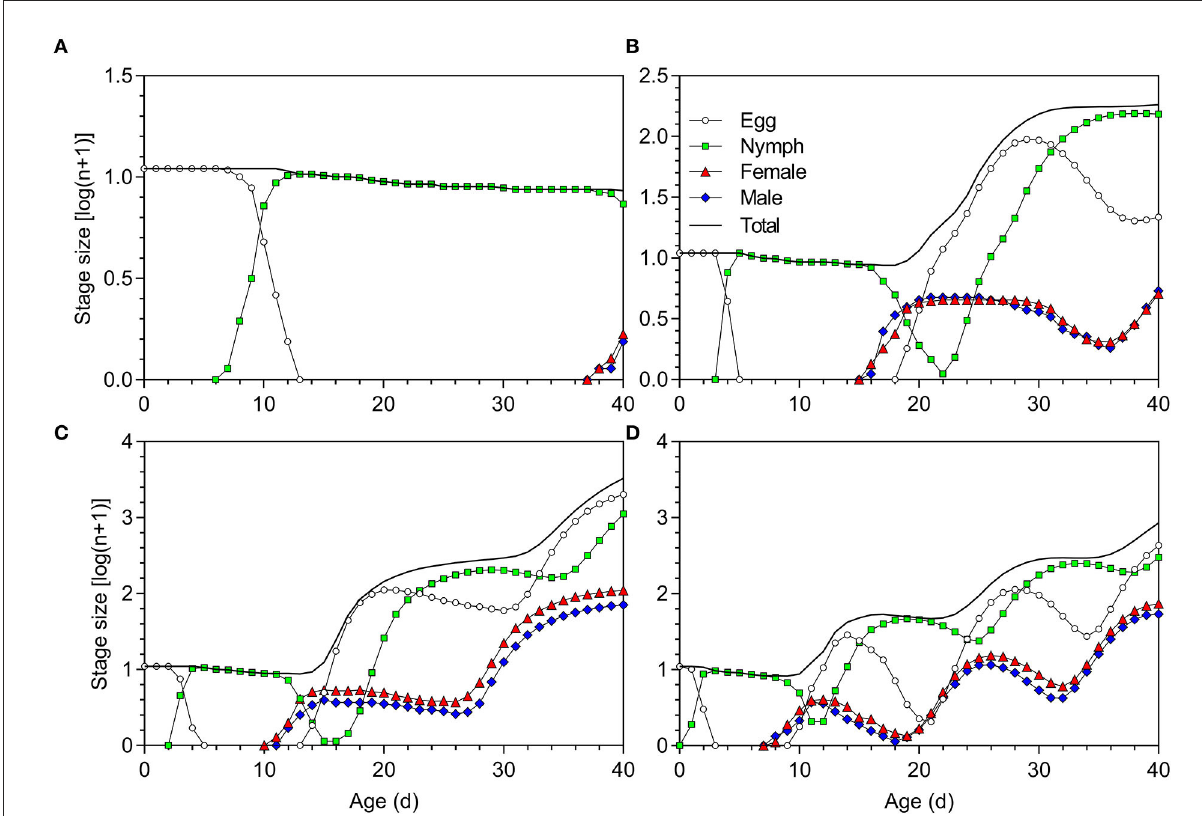
FIGURE6 Population projection of Orius strigicollis fed on Frankliniella occidentalis at (A) 18.5 ◦ C, (B) 23.5 ◦ C, (C) 27 ◦ C, and (D) 33 ◦ C starting with an initial population of 10 viable